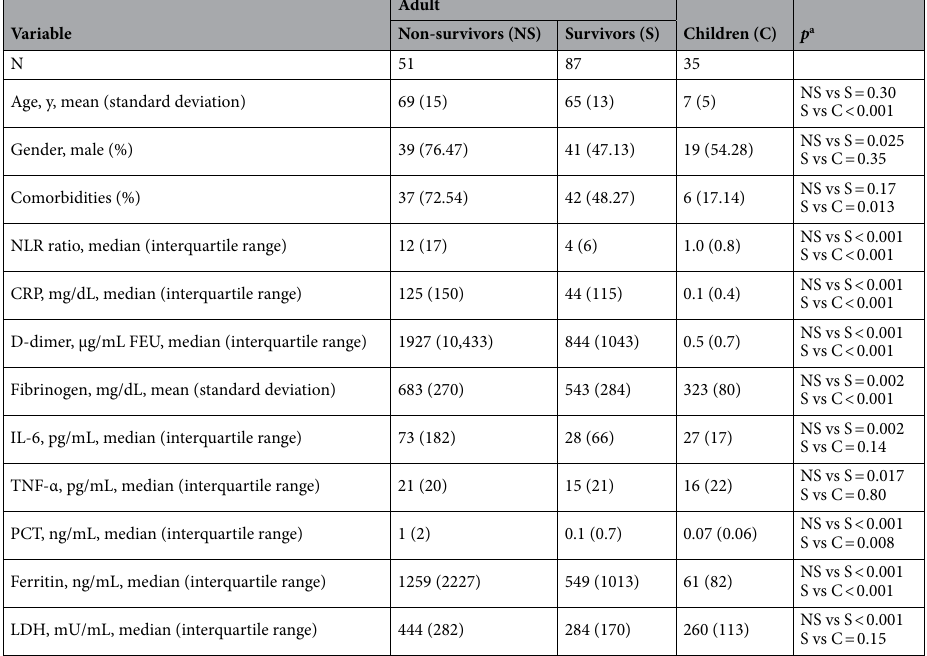
Table 1. General characteristics of the study cohorts. Data are expressed as mean ± standard deviation (SD) or median ± interquartile range (IQR). a Calculated using one-way ANOVA followed by Bonferroni post-hoc test or Kruskal–Wallis test followed multiple comparison of mean ranks for continous variables and χ 2 test for categorical variables.